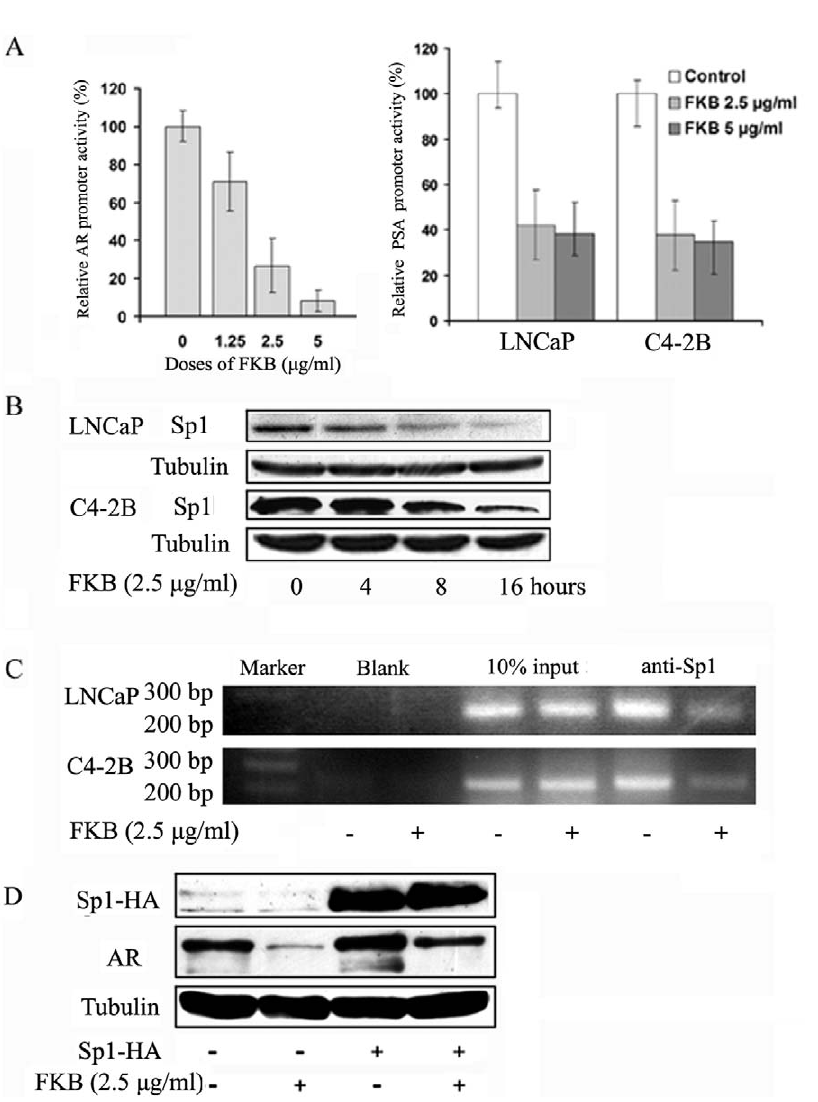
Figure 5. FKB mediated-AR transcriptional repression requires the expression of Sp1. ( A ).C4-2B cells were co-transfected with PSA-Luc or plARS-Luc, along with a Renilla luciferase plasmid pGL 4.71 and Luciferase activities were measured. FKB significantly decreases promoter activities of AR and PSA genes (Student t test, P , 0.01). Bars are mean 6 SD of three independent experiments. ( B ).Western blotting analysis of Sp1 protein expression. A representative blot was shown from three independent experiments. a -Tubulin was detected as a loading control. ( C ). ChIP analysis of the binding of Sp1 to the AR promoter sequence reveals that 16 hours FKB treatment results in a significant decrease in the binding of Sp1 to the AR promoter sequence that contain two Sp1 binding sites. Mouse IgG was used as a blank control. ( D ). Overexpression of Sp1 in C4-2B cells attenuates FKB induced AR protein down-regulation. After 48 hours of Sp1-HA plasmid transfection, C4-2B cells were treated with FKB for 16 hours. Sp1 and AR protein levels were examined. A representative blot was shown from three independent experiments. a -Tubulin was detected as a loading